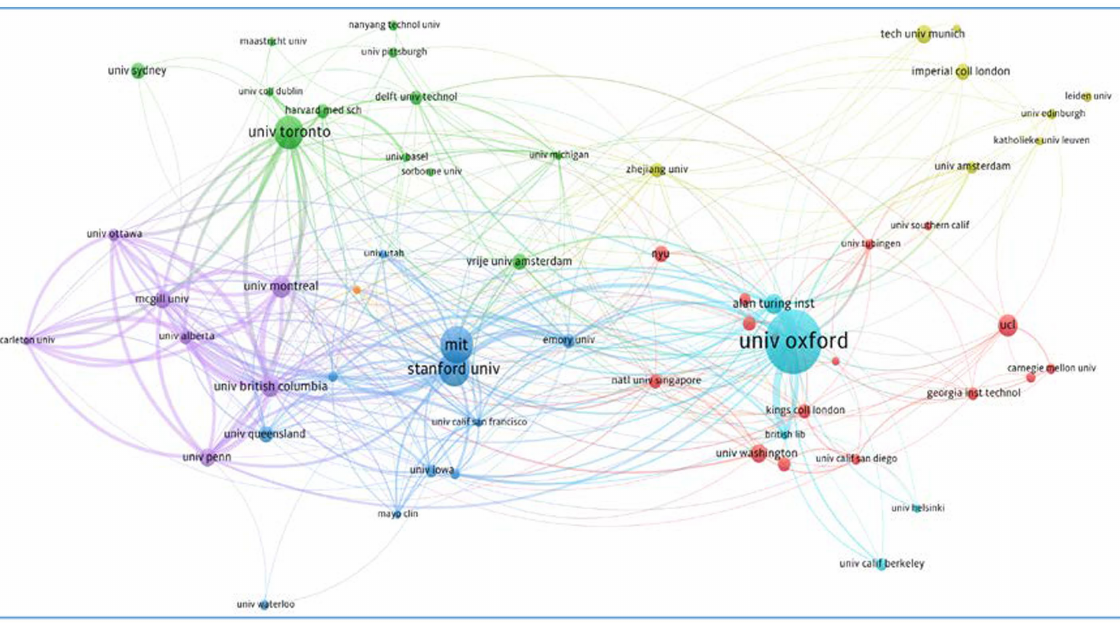
FIGURE 4 The citation networks of organizations.